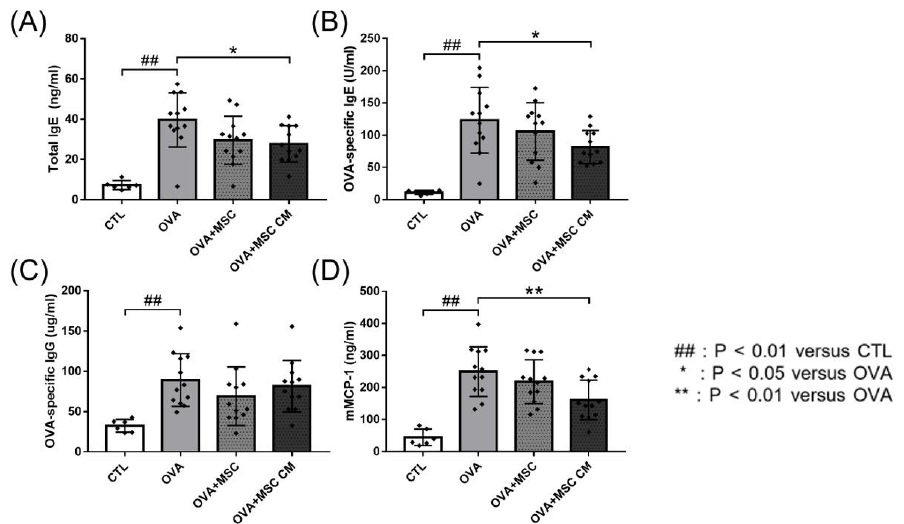
Figure 2. OVA challenge elevated immunoglobulin and mMCP-1 levels and MSC or MSC CM reversed the change. Concentrations of ( A ) total IgE, ( B ) OVA-specific IgE, ( C ) OVA-specific IgG, and ( D ) mMCP-1 in the serum measured by ELISA are shown. Each value indicates mean ± standard error of the mean. ## p < 0.01 versus CTL, * p < 0.05 versus OVA, ** p < 0.01 versus OVA. CTL, control; Ig, immunoglobulin; mMCP, mucosal mast cell protease; MSC, mesenchymal stem cell; MSC CM, mesenchymal stem cell culture medium; OVA, Ovalbumin.